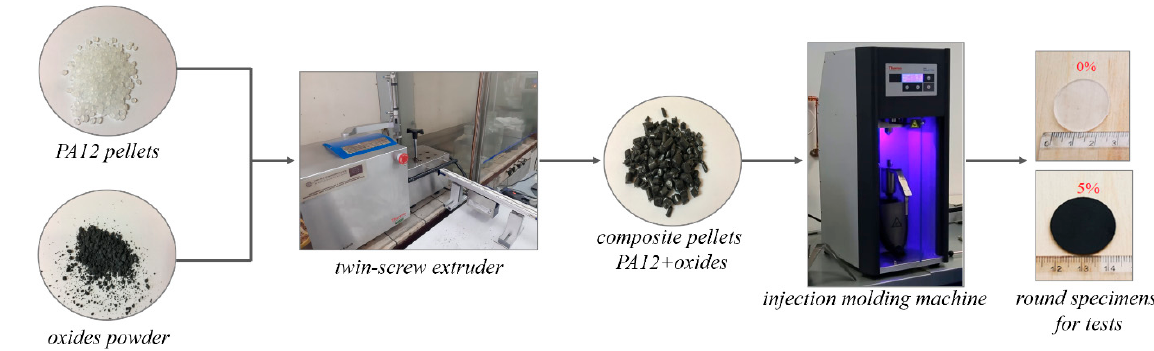
Figure 1. The approach used for the nanocomposite manufacturing.